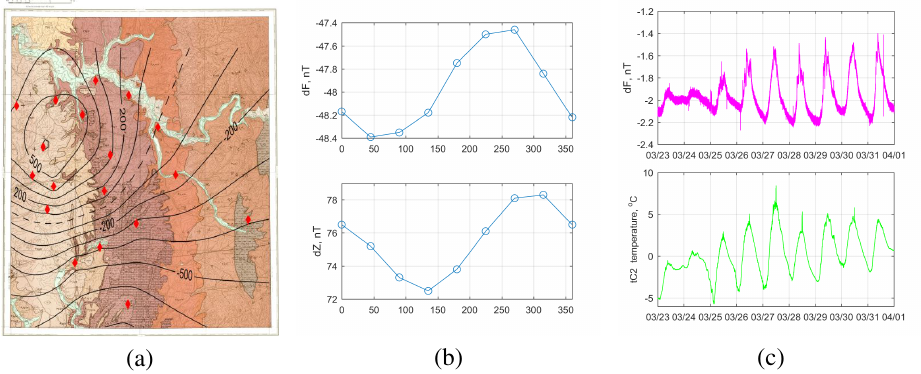
Figure 10. Some results of researches using POS-3 and POS-4 magnetometers: (a) the anomalous sec- ular variation of the vertical component of Earth’s magnetic field for the epoch 2019.5. The isodynamic lines are drawn through 100 nT; (b) a circular diagram for the total field and vertical intensity of POS-3 No.5; (c) presumably, the thermal e ff ect in the titanium solenoid appeared as the di ff erence between the F of POS-3 No.5 and POS-1 against the outdoor